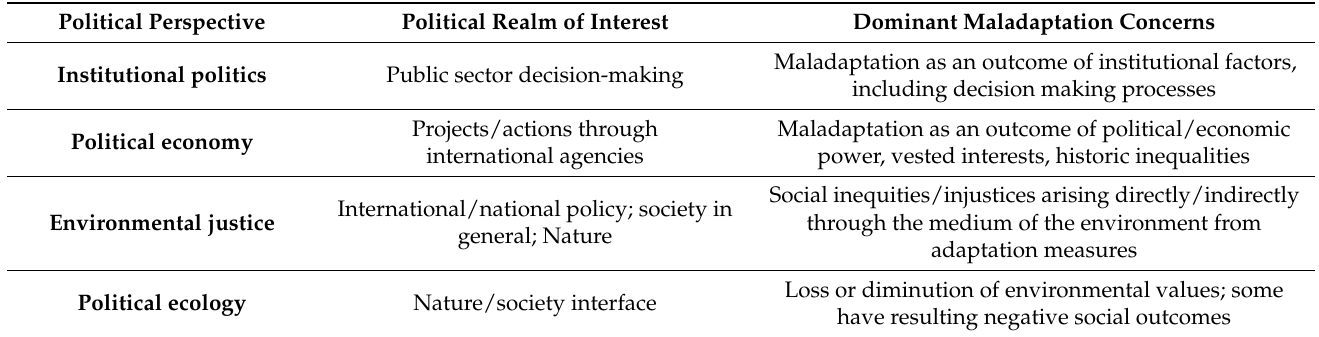
Table 2. Political Perspectives on